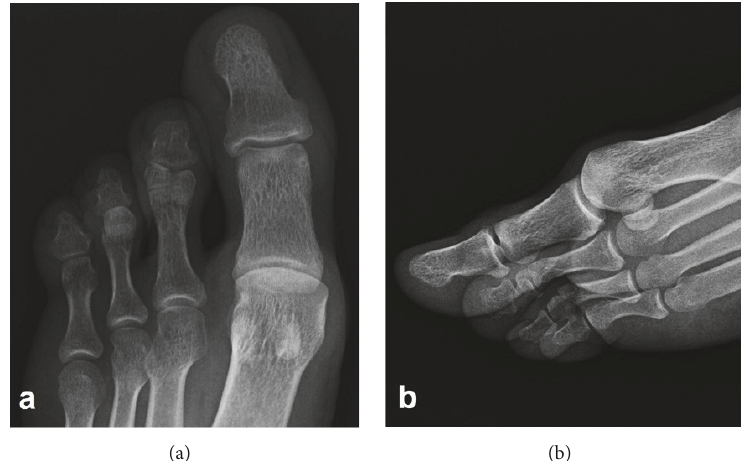
Figure 5: Magnified anteroposterior (a) and lateral oblique (b) radiographs of the left foot show that the middle phalanges of the second and third fingers are shorter than the distal phalanges, and the middle phalanx of the fourth finger is